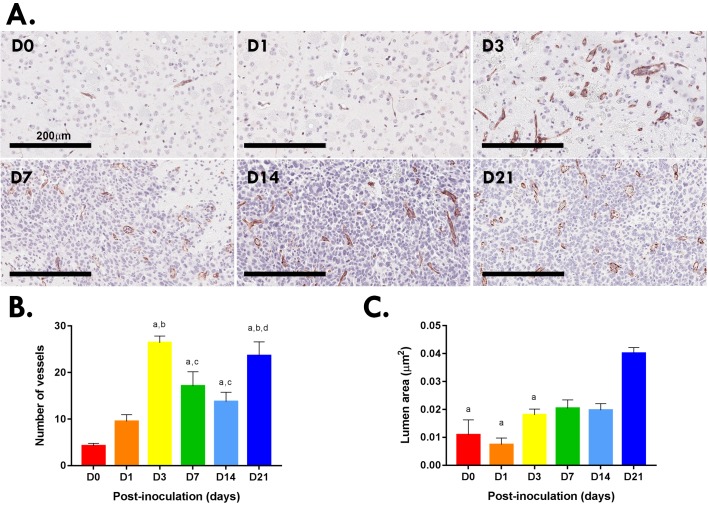
Number of blood vessels in Gl261 gliomas.CD31+ blood vessels at the inoculation site of murine Gl261 gliomas (A). Scale bar, 200μm. Quantitation of blood vessels (B) and lumen area (C) in five HPF (20x) for each murine brain (N = 12 brains per time point; B). Data are expressed as mean ± SEM per HPF. (B) ap<0.05 vs D0, bp<0.05 vs D1, cp<0.05 vs D3, dp<0.05 vs D14 by Tukey’s multiple comparison test. (C) ap<0.05 vs 21 by Tukey’s multiple comparison test.